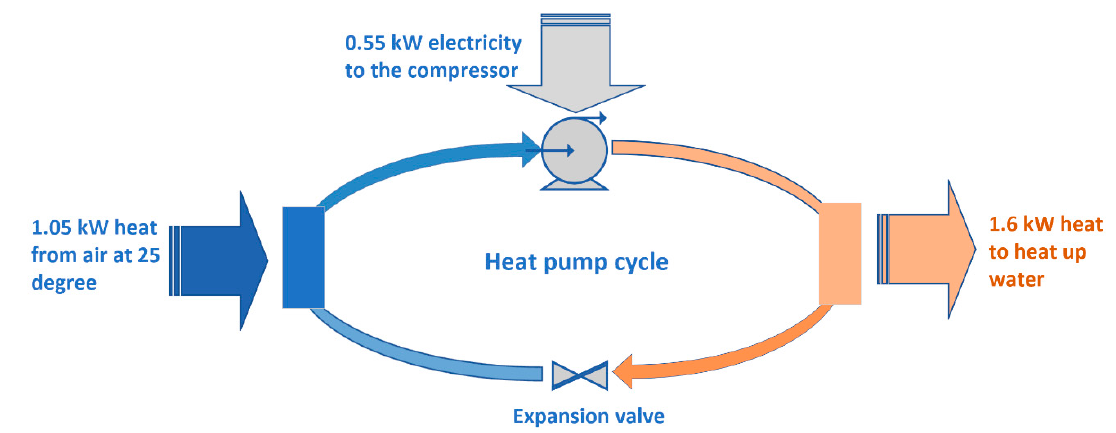
Figure 2. The schematic of energy movement in a heat pump.